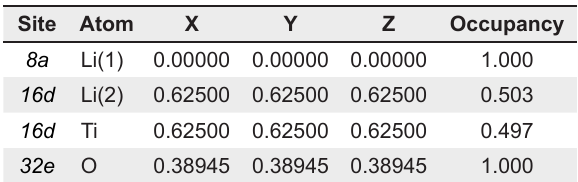
Table 1. The results of Rietveld Analysis of X-ray diffraction data for